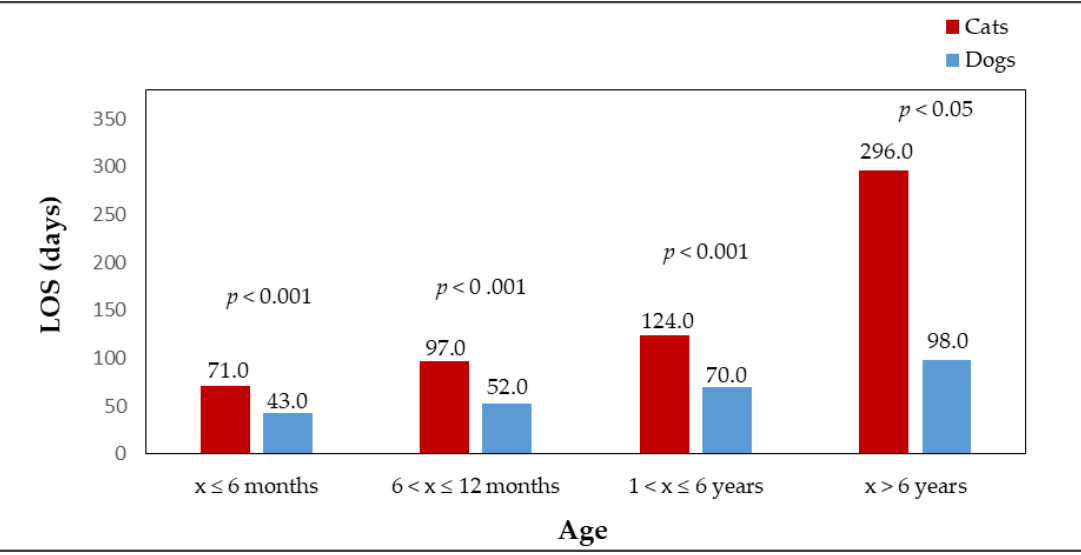
Figure 4. The median LOS of adopted dogs (n = 1051) and cats (n = 356) in four age categories; x = age of an animal.